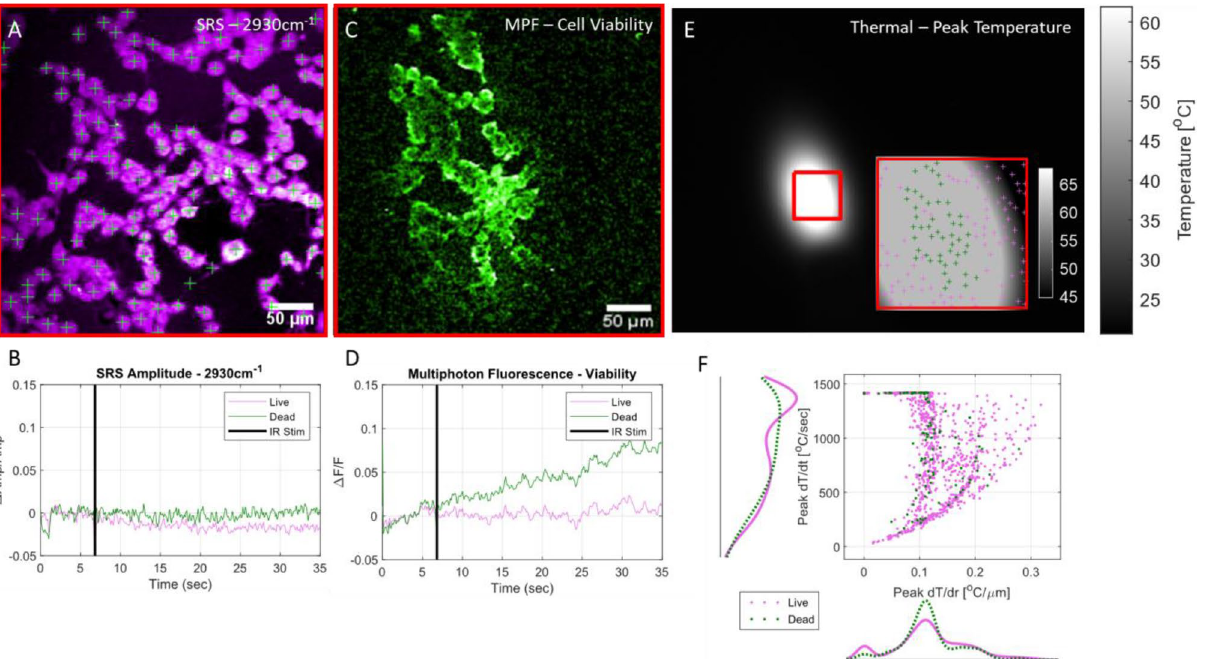
Figure 6. Fast Multimodal Nonlinear and Thermal Microscopy of NG108 cells during infrared neural stimulation—Examples of an ( A ) SRS average intensity projection image of cells with indicated centroids and ( B ) pooled average SRS timeseries of live (magenta) and damaged (green) cells during IR stimulation across all observed cells. ( C ) Example of a normalized sum intensity projection of cell viability image timeseries used to indicate cell viability via uptake and fluorescence of propidium iodide. ( D ) Average pooled MPF timeseries of all observed live and damaged cells during INS. Increases in MPF signal after INS above 3% dF/F over 30 s